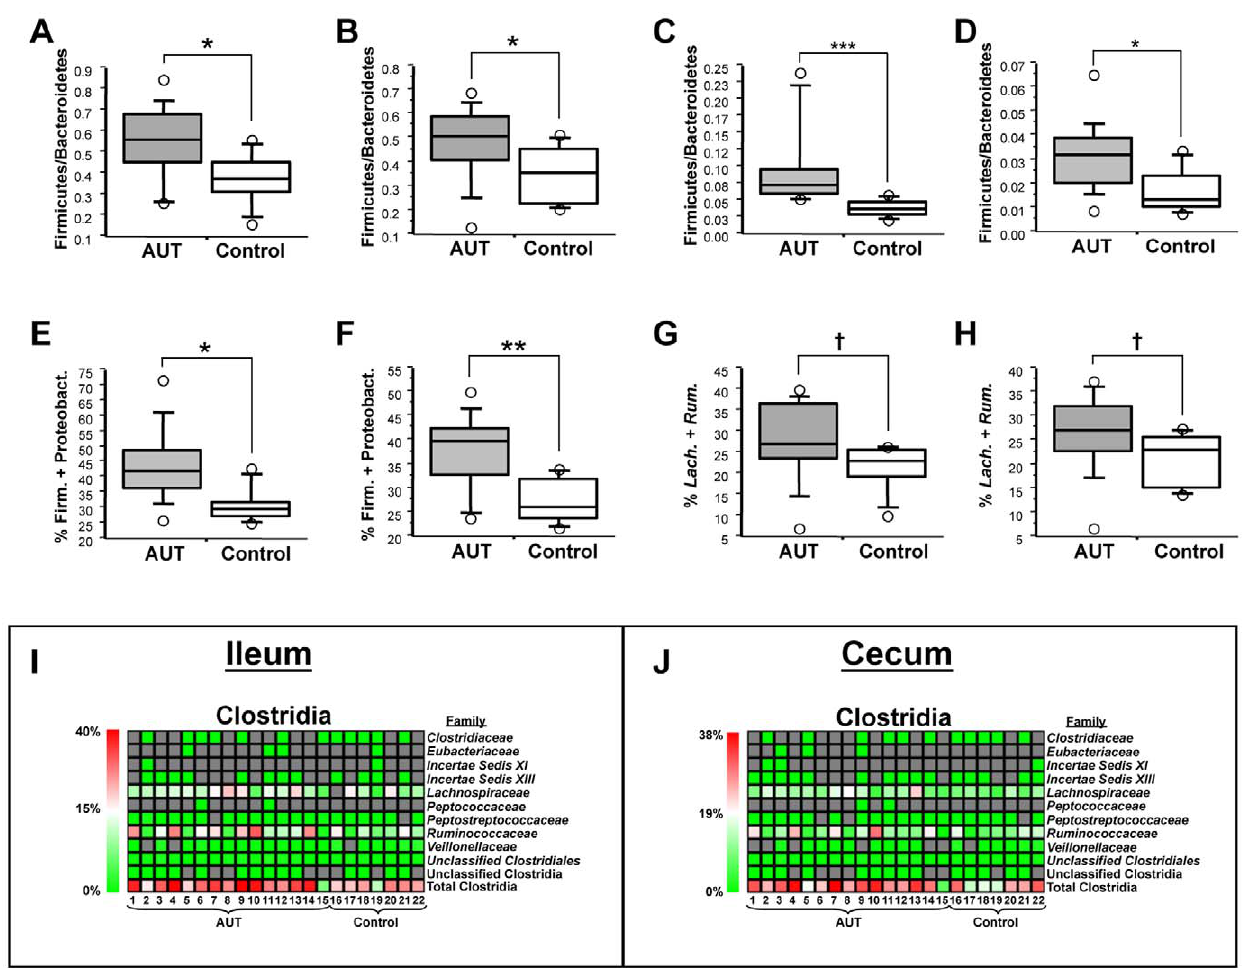
Figure 4. Firmicute/Bacteroidete ratios, Clostridia family abundance, and cumulative levels of Firmicutes and Proteobacteria. ( A–B ) Firmicute/Bacteroidete ratio from pyrosequencing reads obtained from ileal ( A ; Mann-Whitney, p =0.026) and cecal ( B ; Mann-Whitney, p =0.032) biopsies. ( C–D ) Firmicute/Bacteroidete ratios obtained by real-time PCR for ilea ( C ; Mann-Whitney, p=0.0006) and ceca ( D ; Mann-Whitney, p=0.022). ( E–F ) Cumulative abundance of Firmicutes and Proteobacteria from ileal ( E ; Mann-Whitney, p =0.015) and cecal ( F ; Mann-Whitney, p =0.007) biopsies. ( G–H ) Cumulative levels of members of the families Lachnospiraceae and Ruminococcaceae in ileal ( G ; Mann-Whitney; p =0.062) and cecal ( H ; Mann-Whitney; p =0.098) biopsies. ( I–J ) Family-level abundance distributions of the class Clostridia in ileum ( I ) and cecum ( J ): bottom row displays cumulative levels of all family members by patient; gray cells indicate where no sequences were observed for a given taxa. *, p , 0.05; **, p , 0.01; ***, p , 0.001; { , p , 0.1